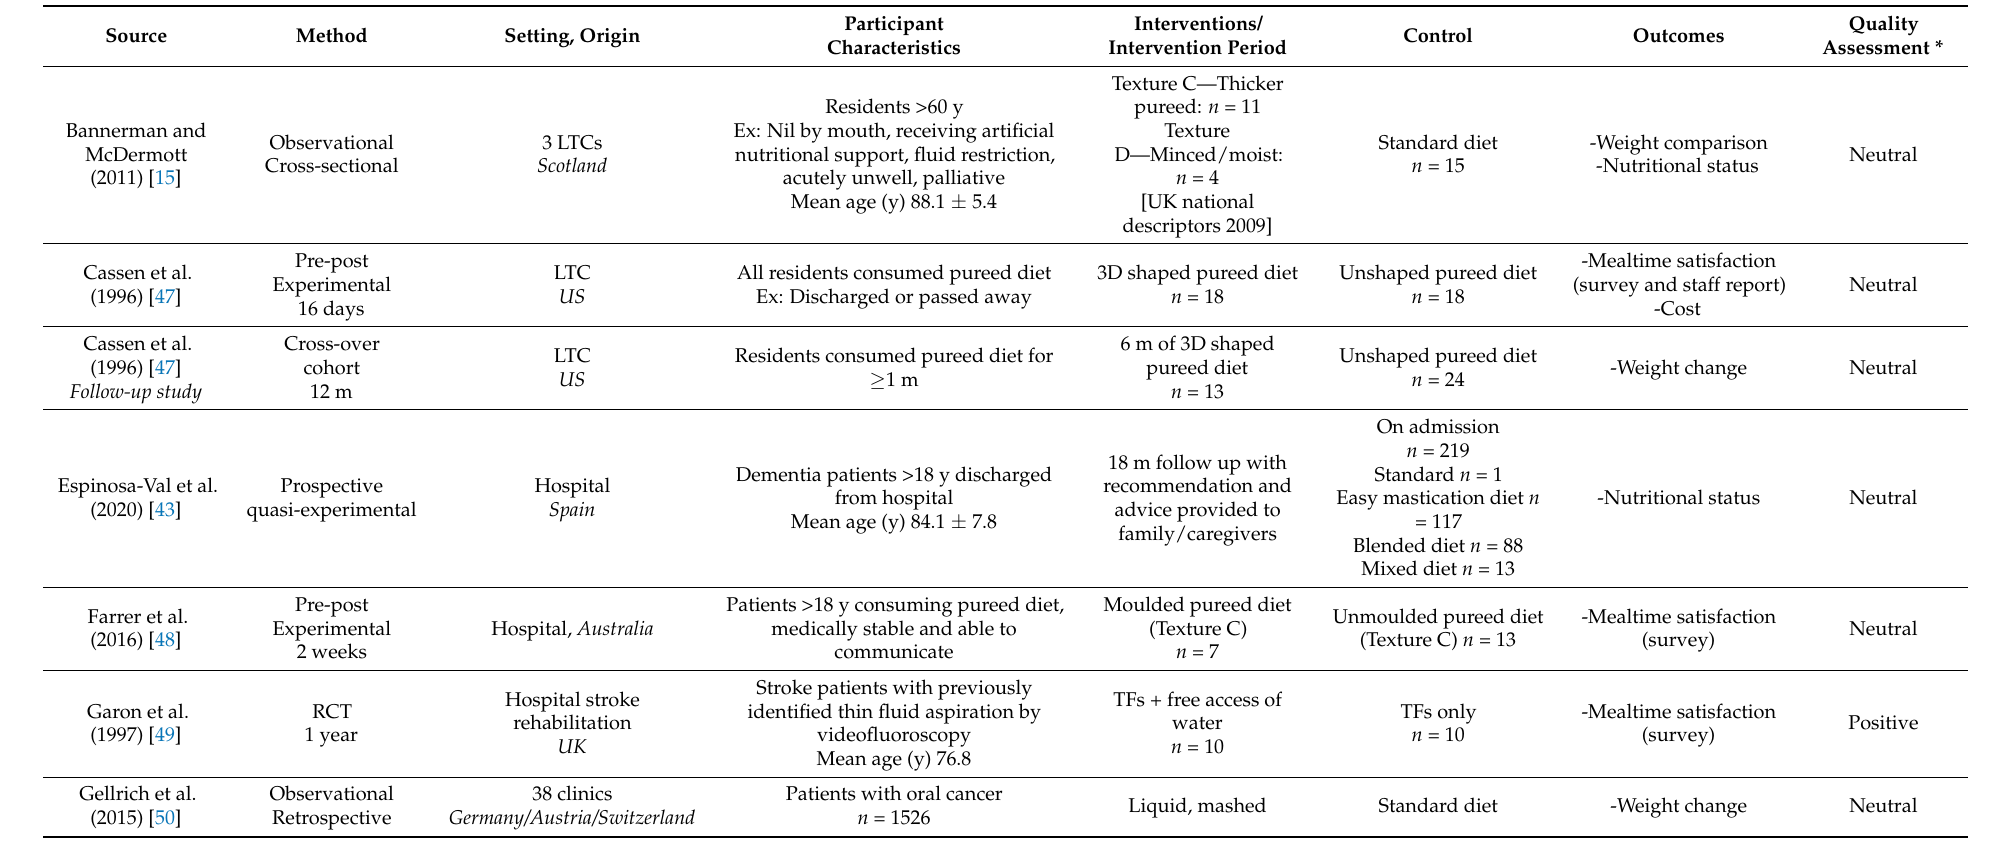
Table 1. Characteristics of included studies in the systematic